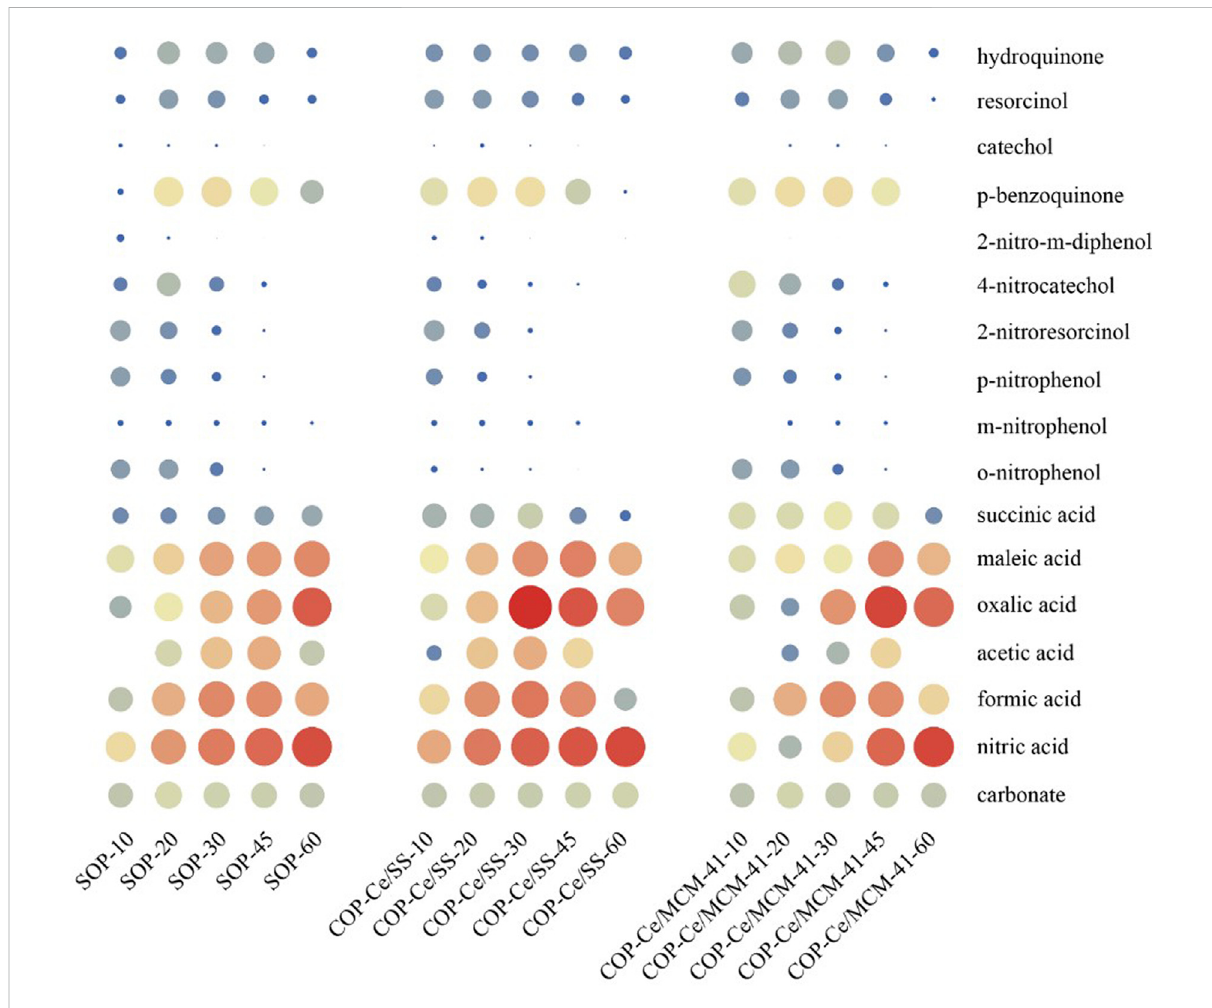
FIGURE 6 Heatmap diagrams of intermediate products of NB degradation in COPs with the Ce/Si